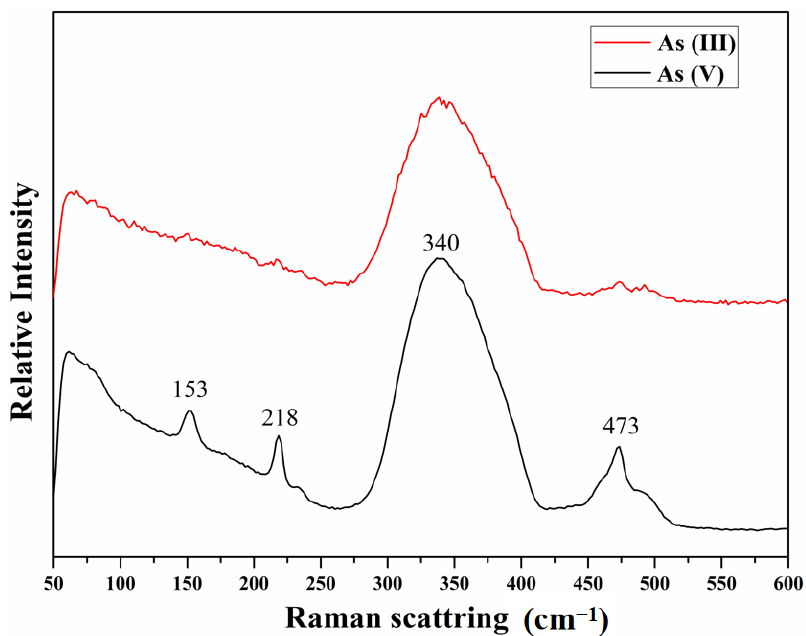
Figure 6. Raman spectra of the precipitate-As(III) and the precipitate-As(V). The FTIR results of the precipitate-As(III) and the precipitate-As(V) are shown in Figure 7. Three peaks at approximately 325 cm − 1 , 355 cm − 1 , and 395 cm − 1 were